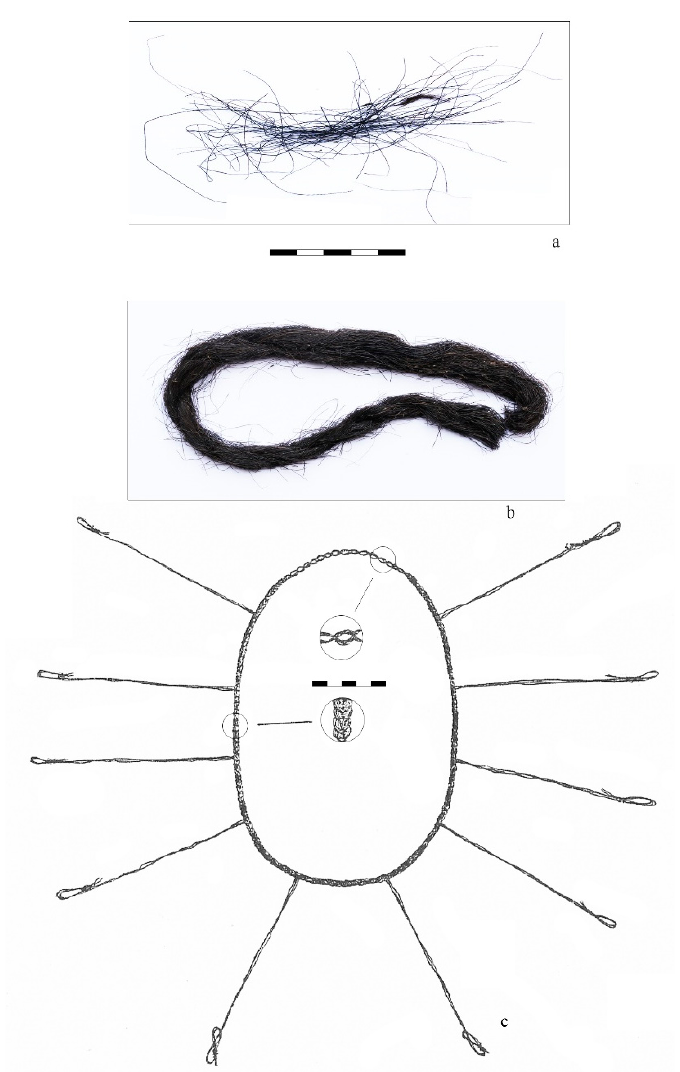
Figure 5. Wroclaw, Ostrów Tumski. Horse hair of tail ( a ) and hair of tail products: string ( b ), ornamental braid ( c ).